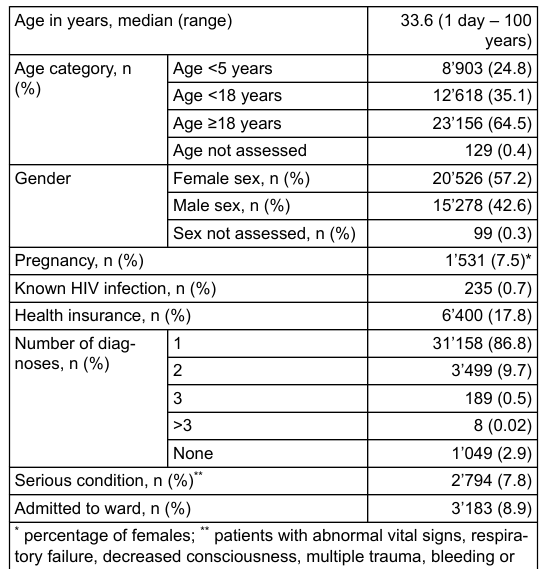
Table 1: Patient characteristics (n = 35’903).